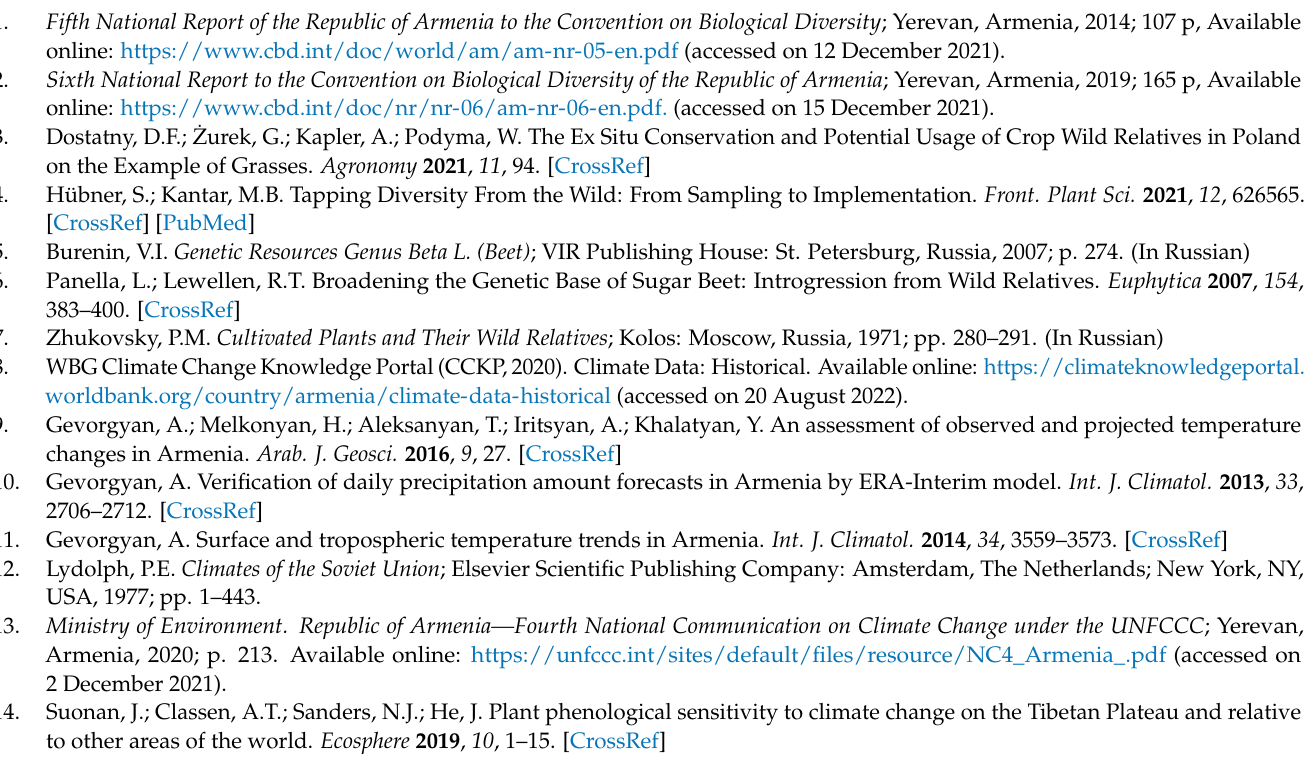
Figure S3: Distribution range of B. lomatogona , B. corolliflora and B.